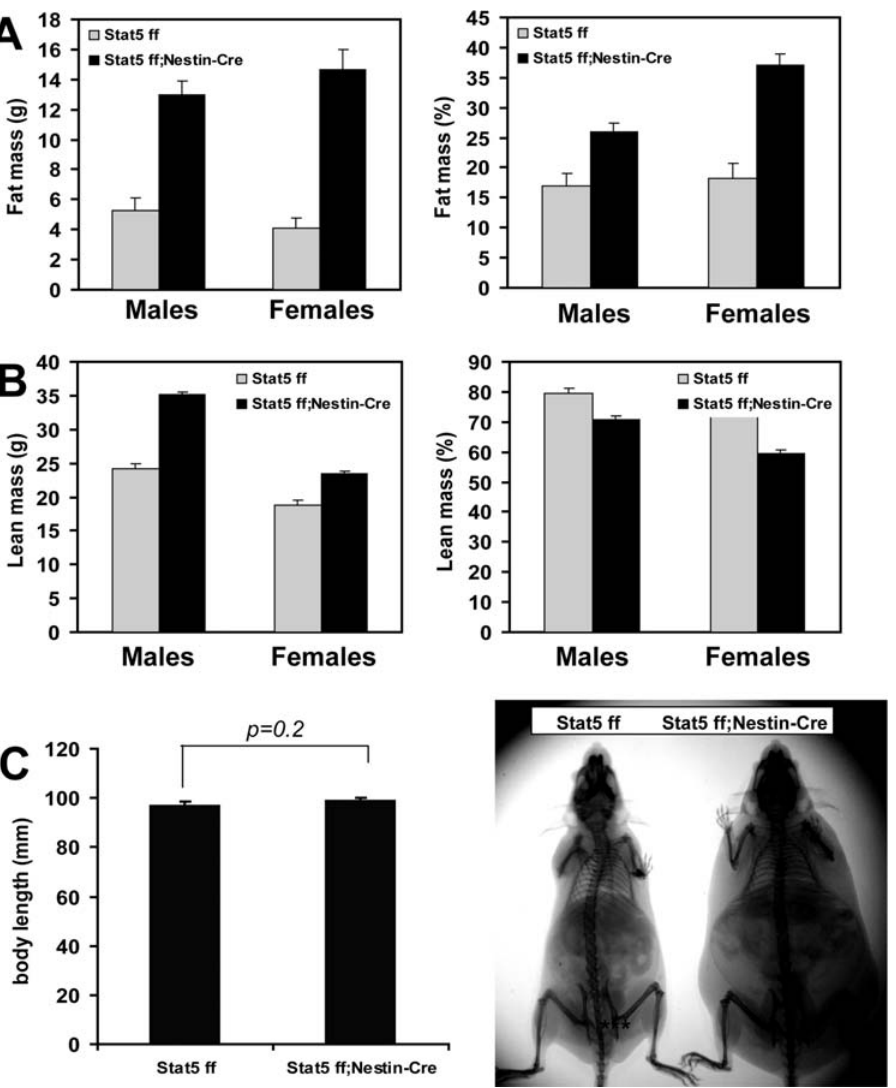
Figure 3. Increased body fat in Stat5 fl/fl;Nestin-Cre mice. (A) Fat mass of 22 week-old males (n=4/group) and females (n=5/group). Left panel shows the amount of fat in grams. By Two Way ANOVA followed by Holm-Sidak test the effect of genotype was significant ( F(1,14)=83.1, P , 0.001). Right panel represents fat mass as a percentage of body weight (F(1,14)=42.4, P , 0.001 for the effect of genotype; F(1,14)=8.0, P=0.014 for the gender effect. (B) Lean mass of 22 week-old males and females in grams (left panel-( F(1,14)=137, P , 0.001 for the genotype effect; F(1,14)=164, P , 0.001 for the gender effect). Right panel presents lean mass as a percentage of total body weight (F(1,14)=70.4, P , 0.001, for the genotype effect, F(1,14)=30.7 for the gender effect). Body weights were: Stat5 fl/fl males 30.5 6 1.5, Stat5 fl/fl; Nestin-Cre males–49.8 6 0.9 g; Stat5 fl/fl females 25.3 6 1.3 g, Stat5 fl/fl; Nestin-Cre females–39.4 6 1.5 g; F(1.14)=143, P , 0.001 for the genotype effect, F(1,14) + 30 for the gender effect. (C) X-ray images of Stat5 fl/fl; Nestin-Cre and Stat5 fl/fl control male mice (right panel) showing similar size of bone length. There was no statistically significant difference in body length as shown in the graph (left panel). doi:10.1371/journal.pone.0001639.g003 was the result of an increased size of individual adipocytes, increased body weight) in male and female Stat5 fl/fl; Nestin-Cre mice was 150% cell number or a combination of both, cell sizes were measured and 200%, respectively of that measured in control mice from paraffin embedded sections. In inguinal, parametrial and (Figure 3A, right panel). Body size, as measured by snout-anus mesenteric fat pads, the mean cross-sectional areas of adipocytes in length, of mutant and control mice was similar (Figure 3C). Stat5 fl/fl; Nestin-Cre mice were significantly larger than this in Stat5 fl/fl At 22 weeks of age, both subcutaneous (Figure 4A) and visceral mice (Figure 4D–F), suggesting increased lipid storage contributes to (Figure 4B) fat mass were increased in Stat5 fl/fl;Nestin-Cre mice the increased fat mass in these animals. compared to Stat5 fl/fl control mice. Individual fat pads from control and mutant female mice were dissected and weighed to evaluate the STAT5 mutant mice have elevated leptin levels and distribution of fat mass. The weight of all 5 fat pads (inguinal, display insulin resistance parametrial, retroperitoneal, mesenteric and perirenal) in mutant mice was at least doubled in mutant compared to control animals Serum analysis of fed mice demonstrated elevated levels of TG, (Figure 4C). To determine whether increased adipose tissue mass FFA, insulin and leptin in 22 week-old mice Stat5 fl/fl ; Nestin-Cre mice